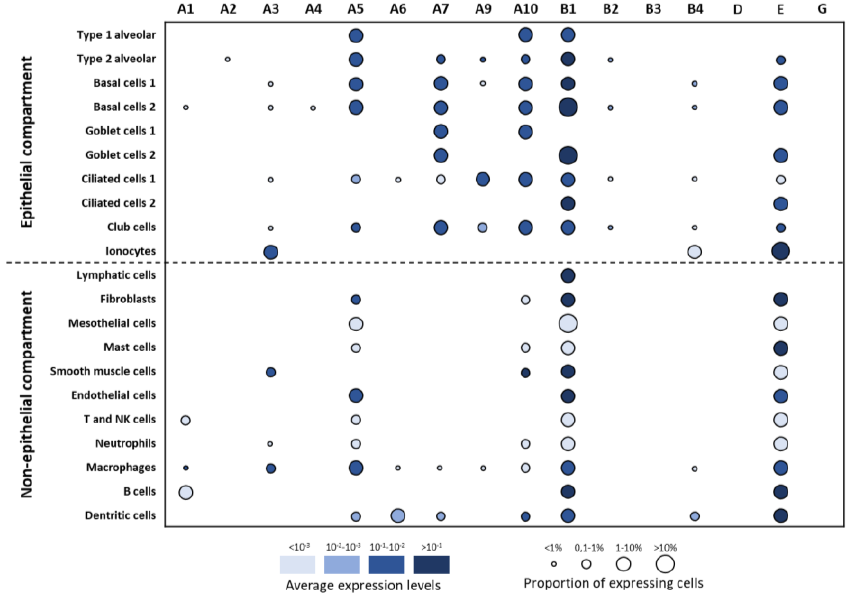
Figure 4. Evaluation of nAChR expressions in lung single-cell populations. Dot plots of nAChR expressions in the epithelial and non-epithelial compartments. The identities of cell populations are shown on the y-axis, and the subunits on the x-axis. The colour intensity represents the average expression level, and the size of the dots represents the proportion of the expressing cells in each population. Raw expression values were normalized, log-transformed, and summarized by published cell clustering.